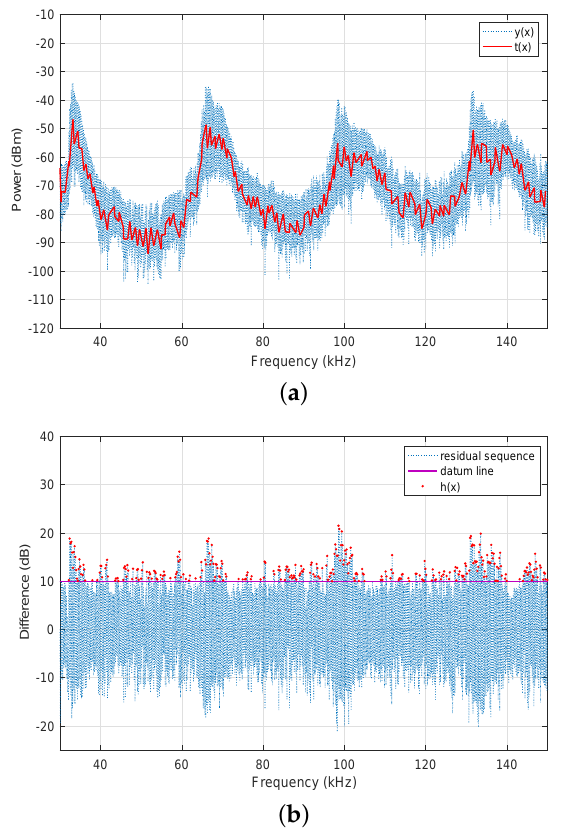
Figure 2. B-spline curve fitting-based algorithm for the spectrum of a fluorescent table lamp: ( a ) original data y ( x ) and fitting curve t ( x ) ; ( b ) residual sequence after removing the broadband component and obvious narrowband sequence h ( x ) .